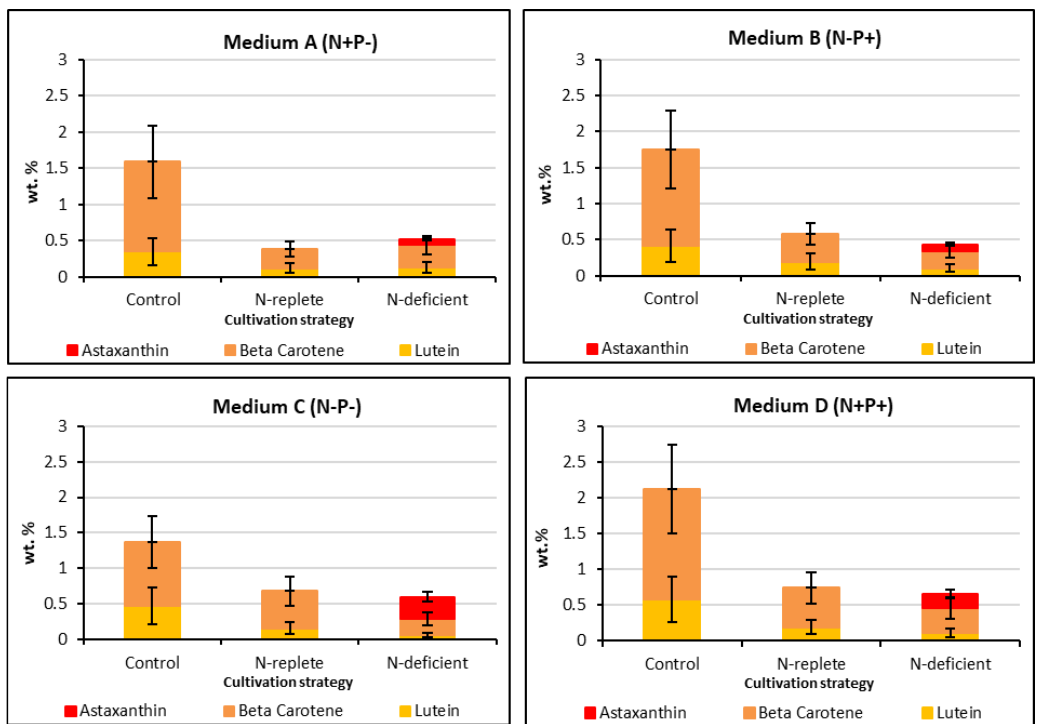
Figure 7. Carotenoids produced by Coelastrella sp. from the four BG-11 modified media combina- tions of N/P concentrations (A: N+P-, B: N-P+, C: N-P-, D: N+ P+) and further sub-categorized by the three subsequent carotenogenesis strategies: control, N-replete, N-deficient. Error bars represent the coefficient of variation.